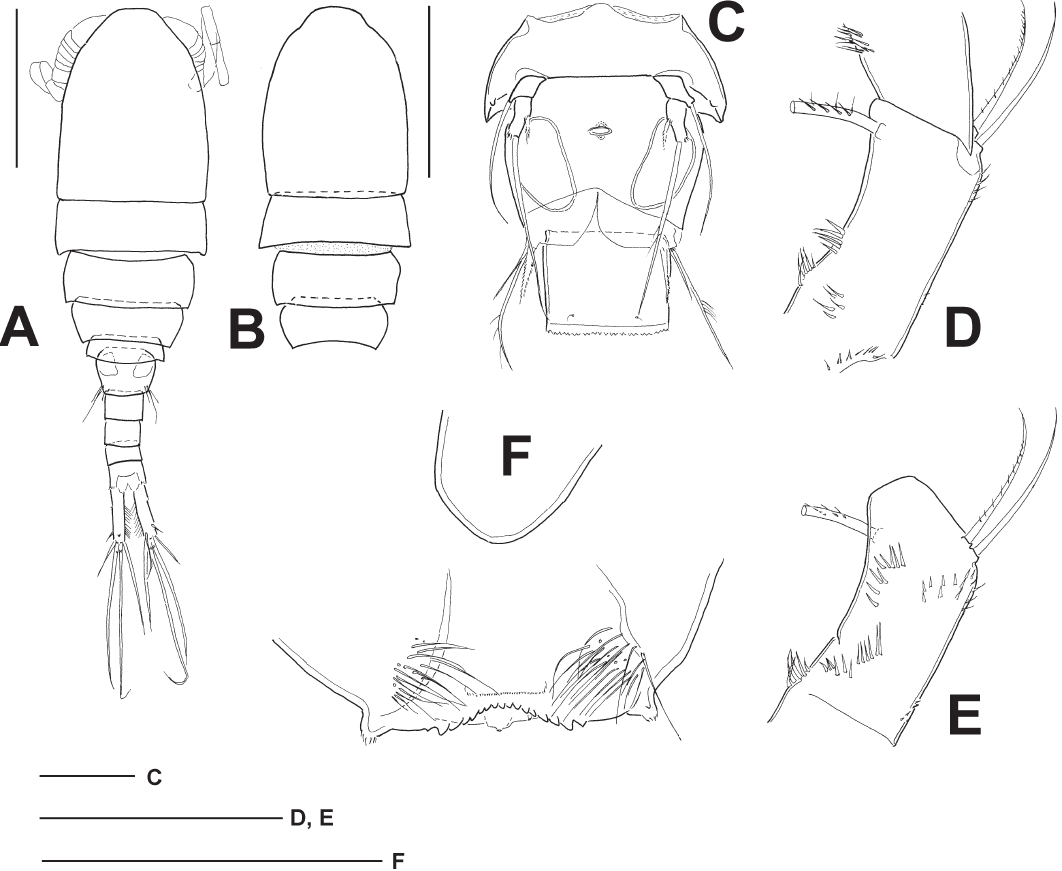
Fig. 4. Cyclops bohater koźmiński, 1933, ♂. A . Habitus, dorsal. B . Prosome with distinctly wide pediger 2. C . Pediger 5, genital segment, and first abdominal segment, ventral. D−E . antennal coxobasis. D . Frontal. E . caudal. F . Labrum. except for B (Lake Largen, sweden − miZ 2/2016/15) all drawings show a paralectotype (nHmUk 2016. 40). scale bars: a−B = 500 µm; c−F =